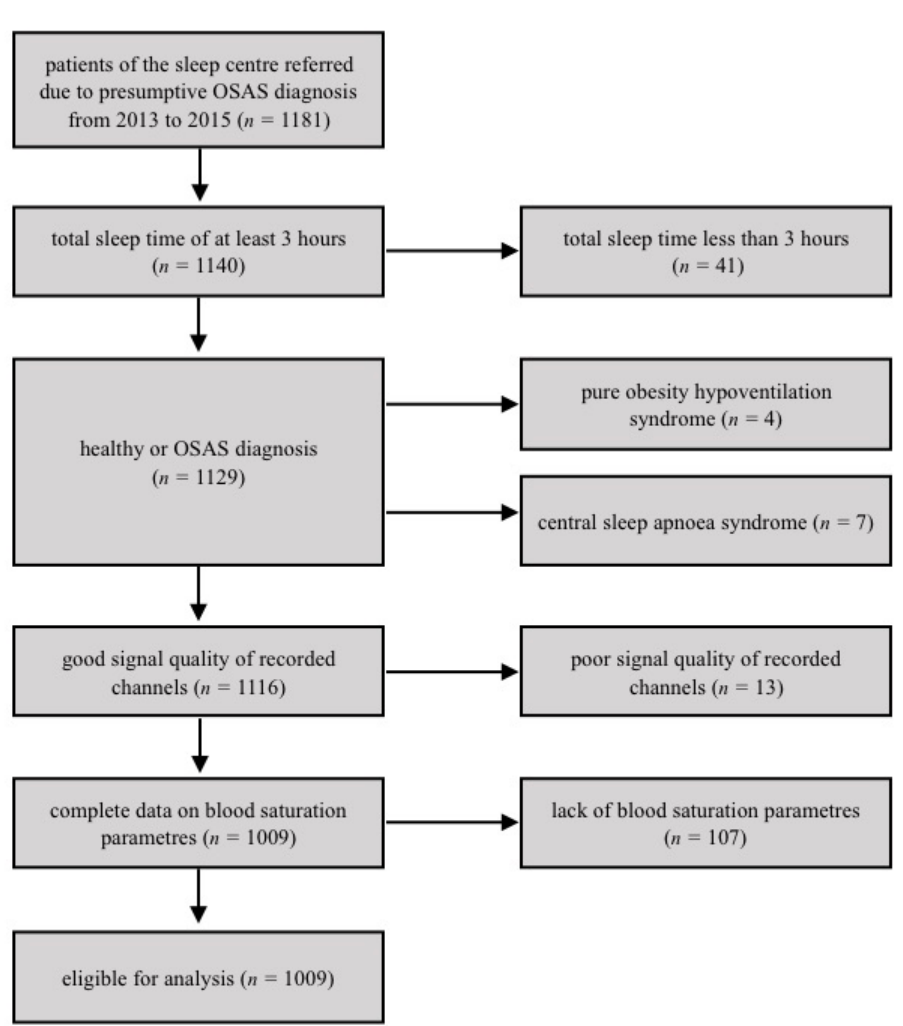
Figure 1. Flow chart showing selection of the patients eligible for the analysis in the studied group of patients with suspected obstructive sleep apnea syndrome (OSAS). n —number of